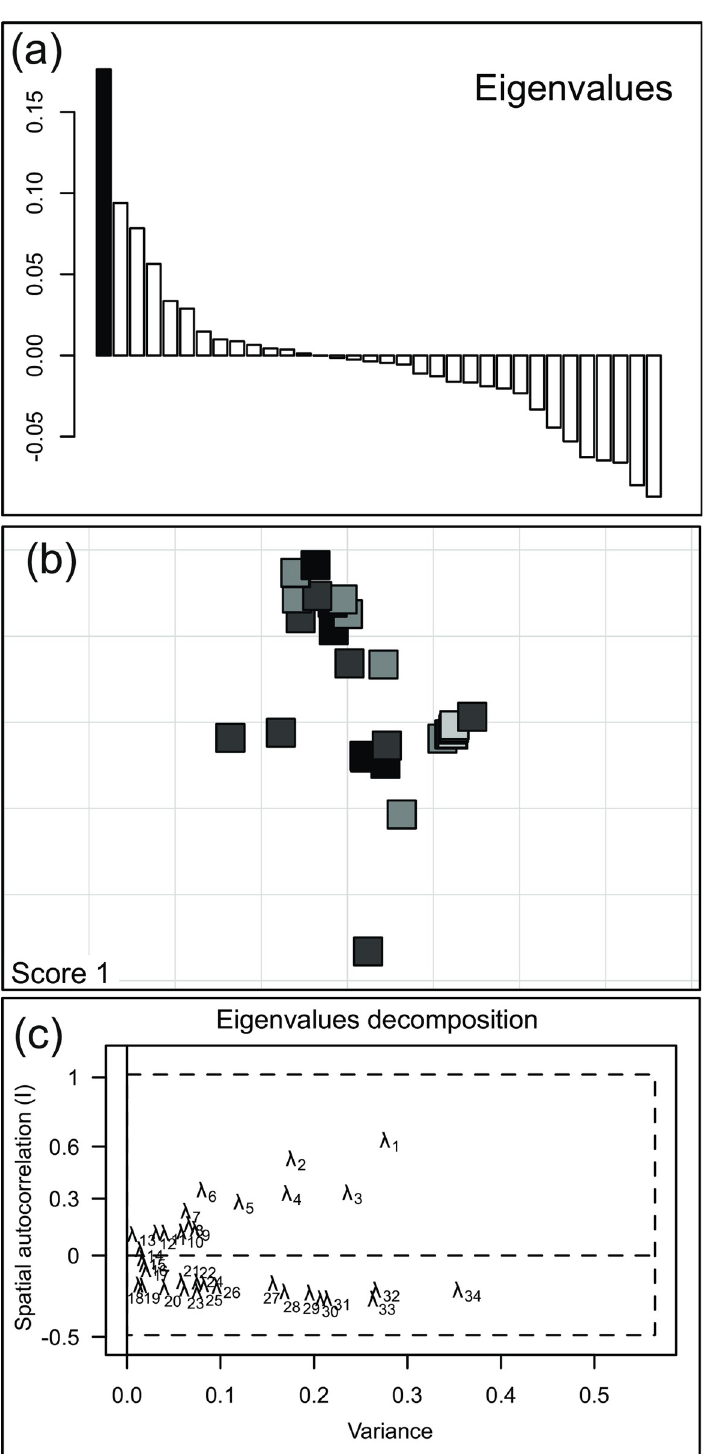
Fig 2. Results of the spatial principal component analysis (sPCA) for contemporary Białowie ż a Primeval Forest and Narew-Biebrza river populations based on 11 microsatellite loci. a) Eigenvalue plot and b) screenplot show that the first axe is the most important explaining the genetic variation that is not statistically significant (p < 0.05). c) Scores in space; grey levels are used for different absolute values with black and white being well differentiated.